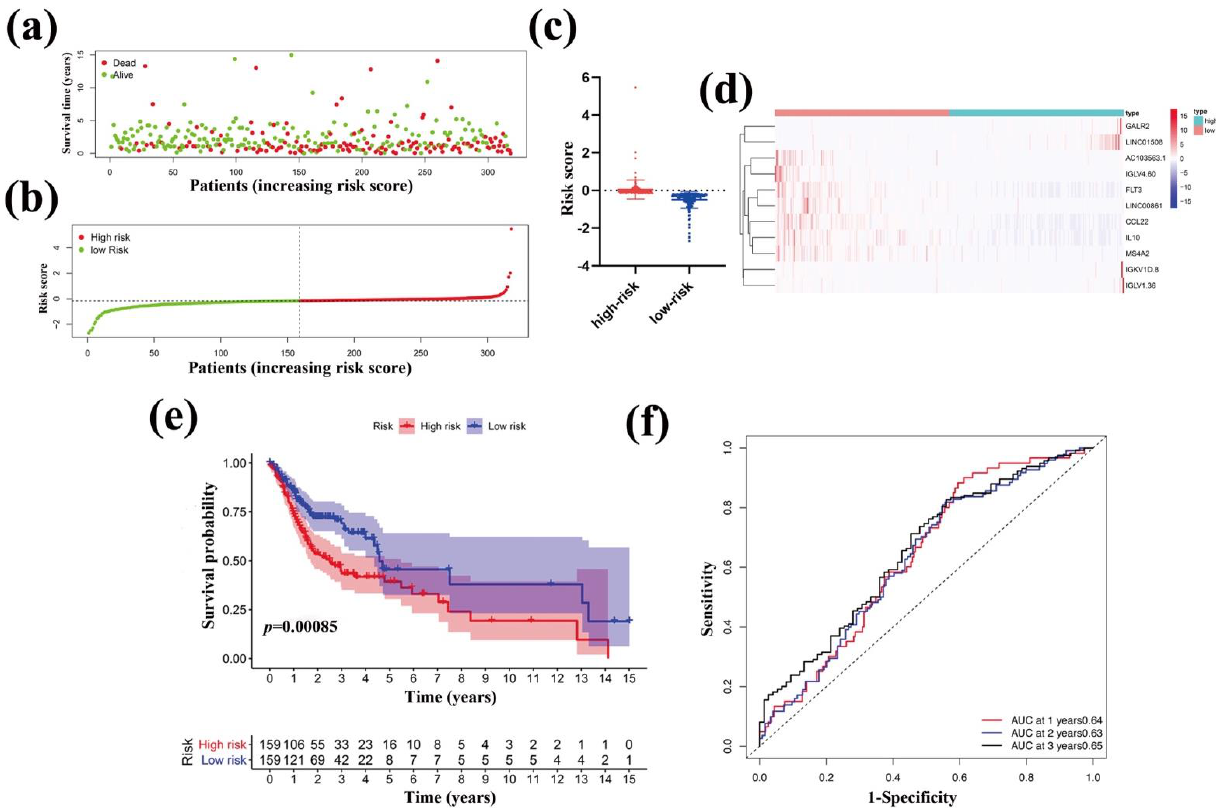
Figure 8. Prognostic effect of the immune-related signature. The survival status ( a ), risk scores ( b , c ) of OSCC patients, and heatmap of immune-related DEGs expression pattern ( d ). Kaplan-Meier survival curve ( e ) for OS of the low-risk and high-risk groups of OSCC patients. ( f ) Prognostic value evaluation of the 11-gene signature using time-specific ROC curves and dynamic AUC lines analysis. The time-dependent ROC curves are based on 1, 2, and 3 years of follow-up and the dynamic AUC lines of OSCC patients.